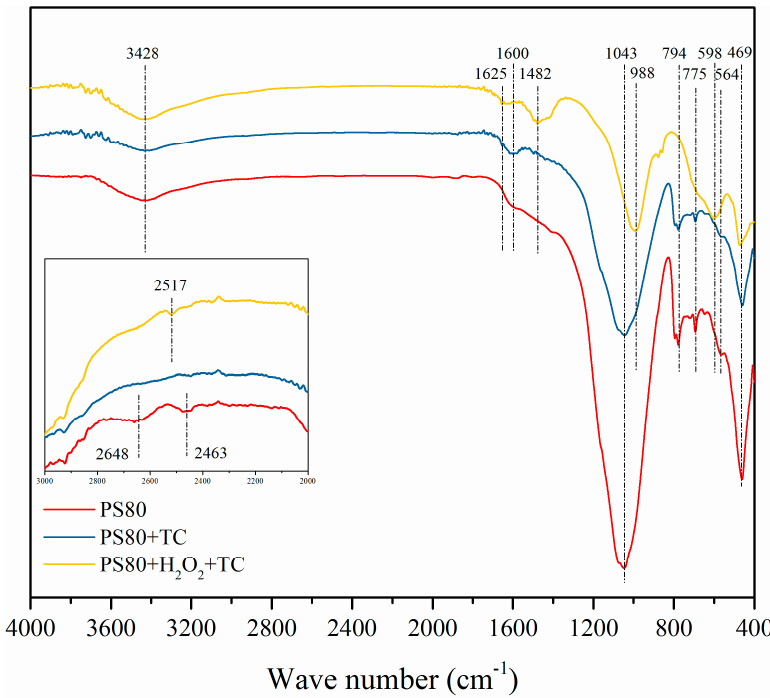
Figure 6. FTIR spectra of the PS80, PS80+TC, and PS80+H 2 O 2 +TC samples. Table 5. Comparison of the removal capacity for TC with other materials reported in the literature. Table 4. Functional groups of biochar before and after TC